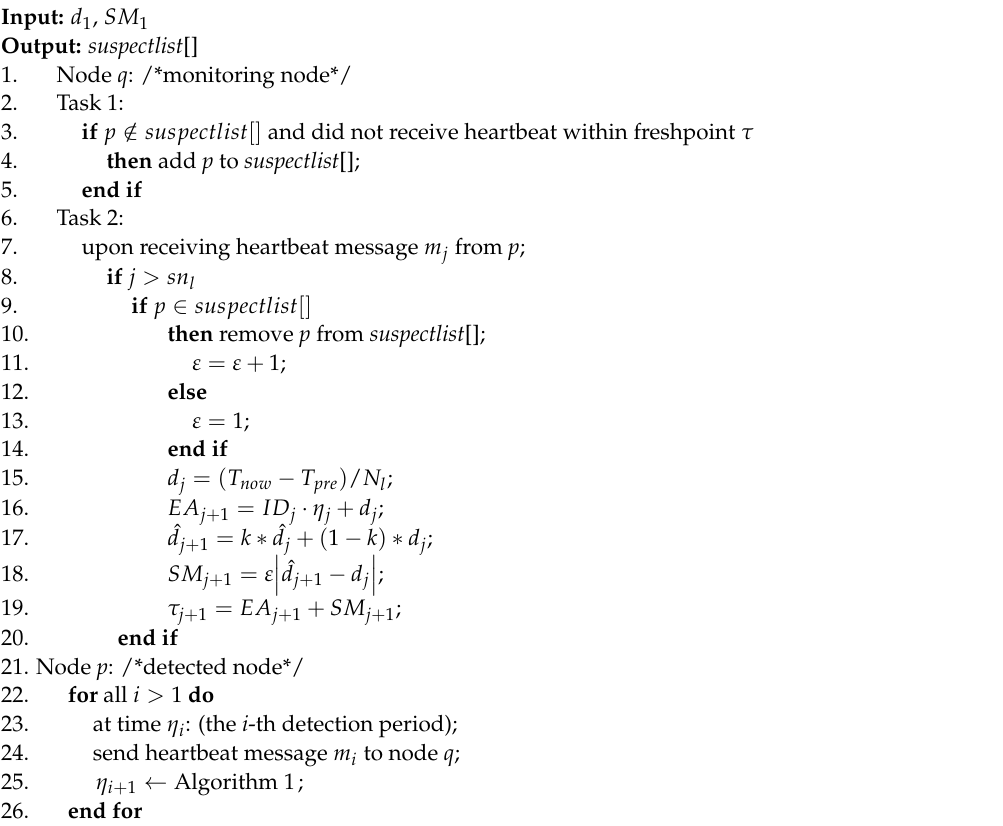
Algorithm 2. Low-power Failure